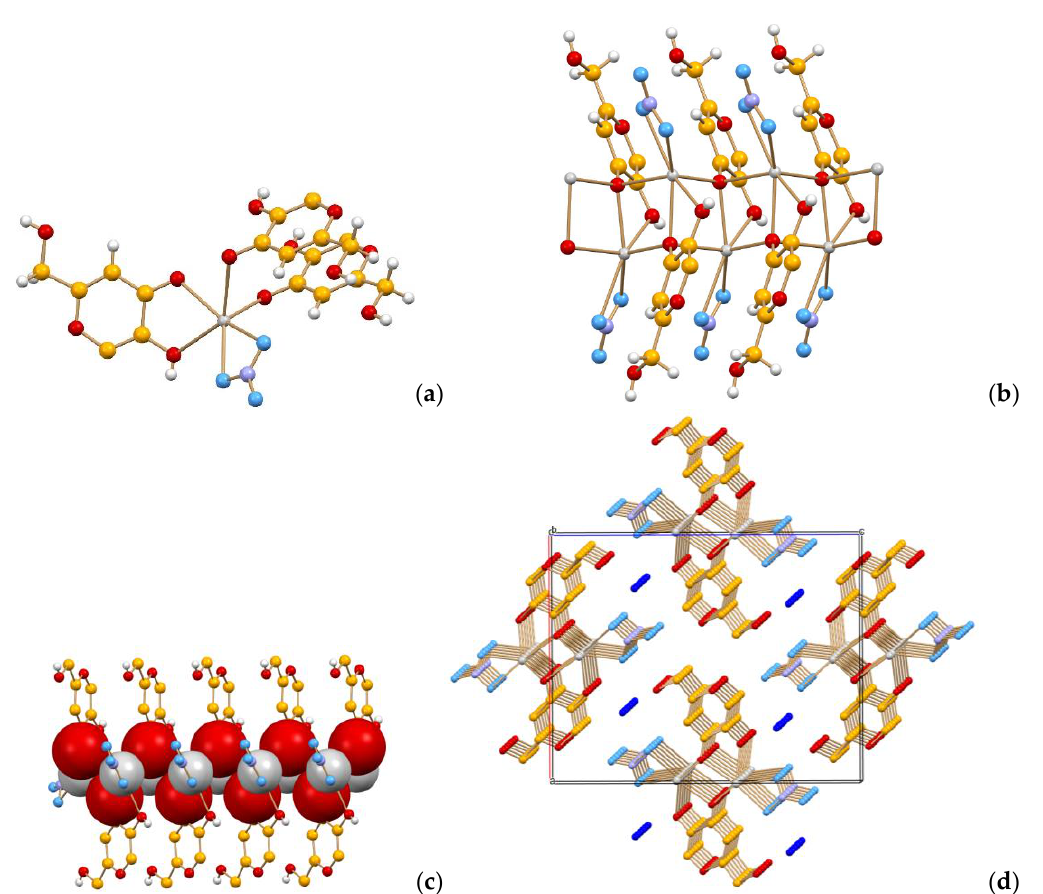
Figure 1. Coordination around the silver(I) ion in crystalline [Ag(HKA)(NO 3 )] · H 2 O ( a ). The 1D ribbon, extending along the crystallographic a -axis, formed by the silver–oxygen backbone and the coordinated kojic acid molecules and nitrate ions ( b , c ) (H CH atoms not shown for clarity). View of the packing down of the crystallographic b -axis, showing the water molecules (in blue) filling in the channel in between the 1D ribbons ( d ) (H atoms not shown for clarity). Water oxygen in blue, nitrate oxygens in cyan, and silver ions in light grey.